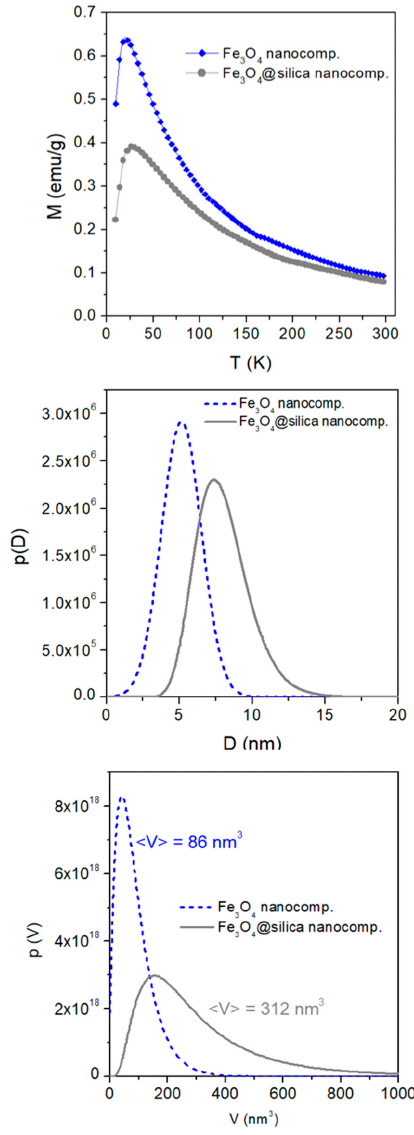
Figure 3. ( Top panel ) experimental ZFC magnetization curves of the Fe 3 O 4 and Fe 3 O 4 @silica NCs; ( center panel ) corresponding normalized p(D) curves obtained from Equation (1); ( bottom panel ) corresponding volume distribution functions p(V). <V> is the resulting mean value of magnetic-unit volume.